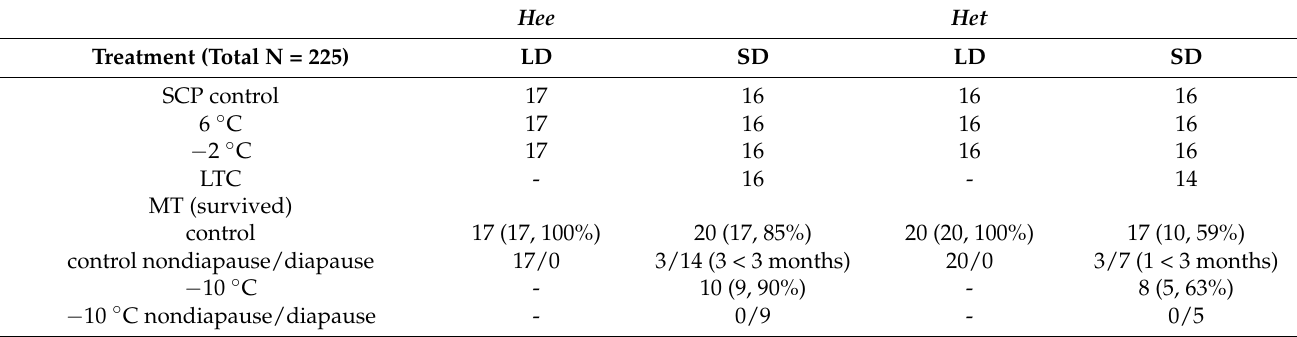
Table 2. Overview and sample size of all studied groups (SCP analyses and mortality tests): Hee–‘euphorbiae’, Het– ‘tithymali’, LD–long-day breeding conditions, SD–short day, SCP control–without cold treatment, 6 ◦ C and − 2 ◦ C–cold treatments, MT control–mortality test groups without cold treatment, − 10 ◦ C–cooled mortality test groups, LTC–long-term cold treatment, N–number of individuals per